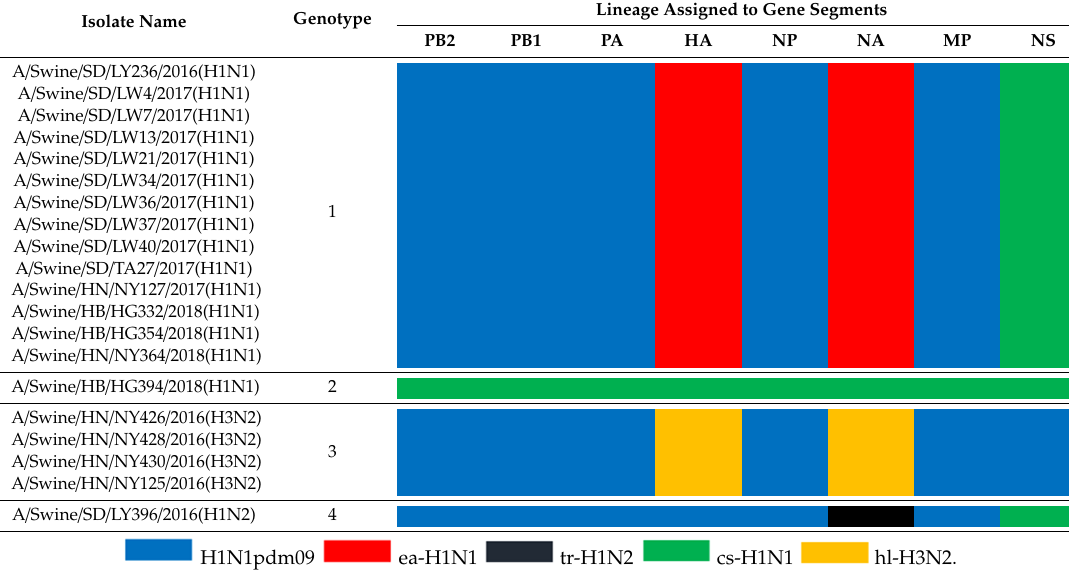
Table 2. The genotypes of all isolates.